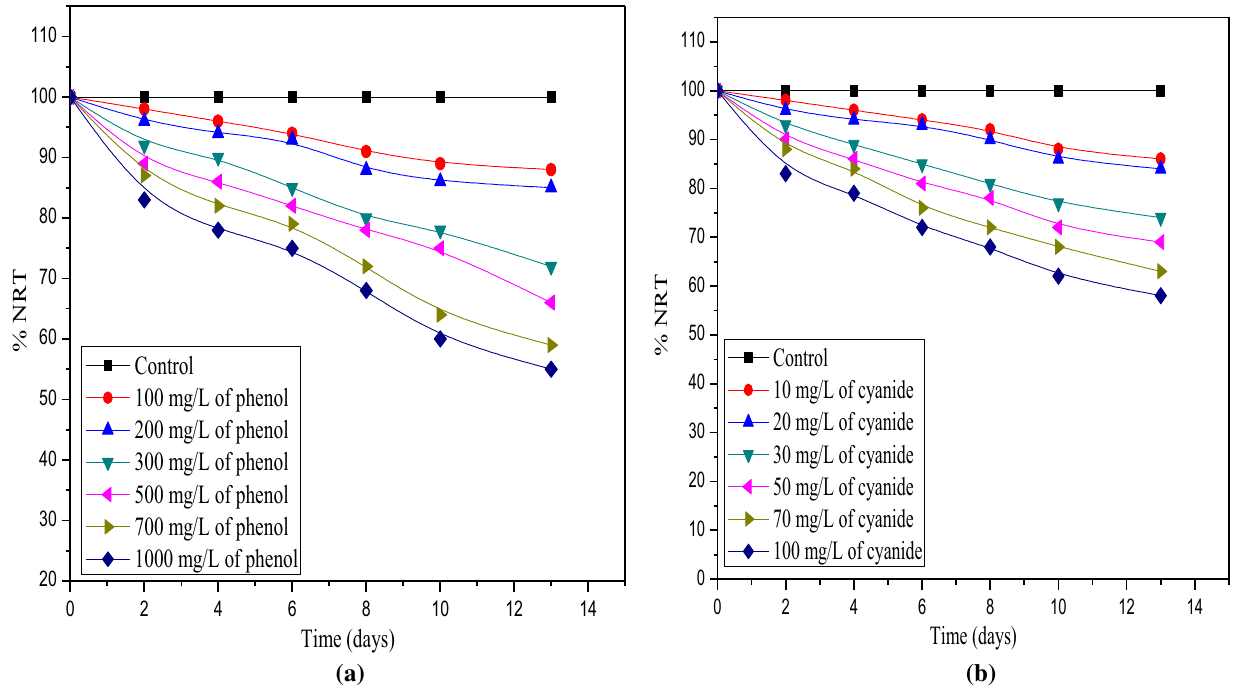
Fig. 10 Relative transpiration of Eichhornia crassipes at different concentrations. a Phenol b